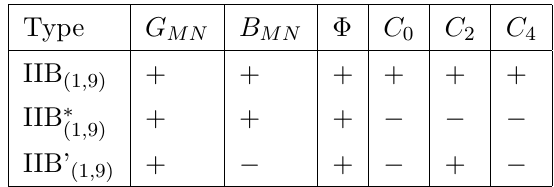
Table 7 . Relative signs for kinetic terms in ten-dimensional type-IIB theories. A + indicates the standard sign for a theory in Lorentz signature using the mostly plus